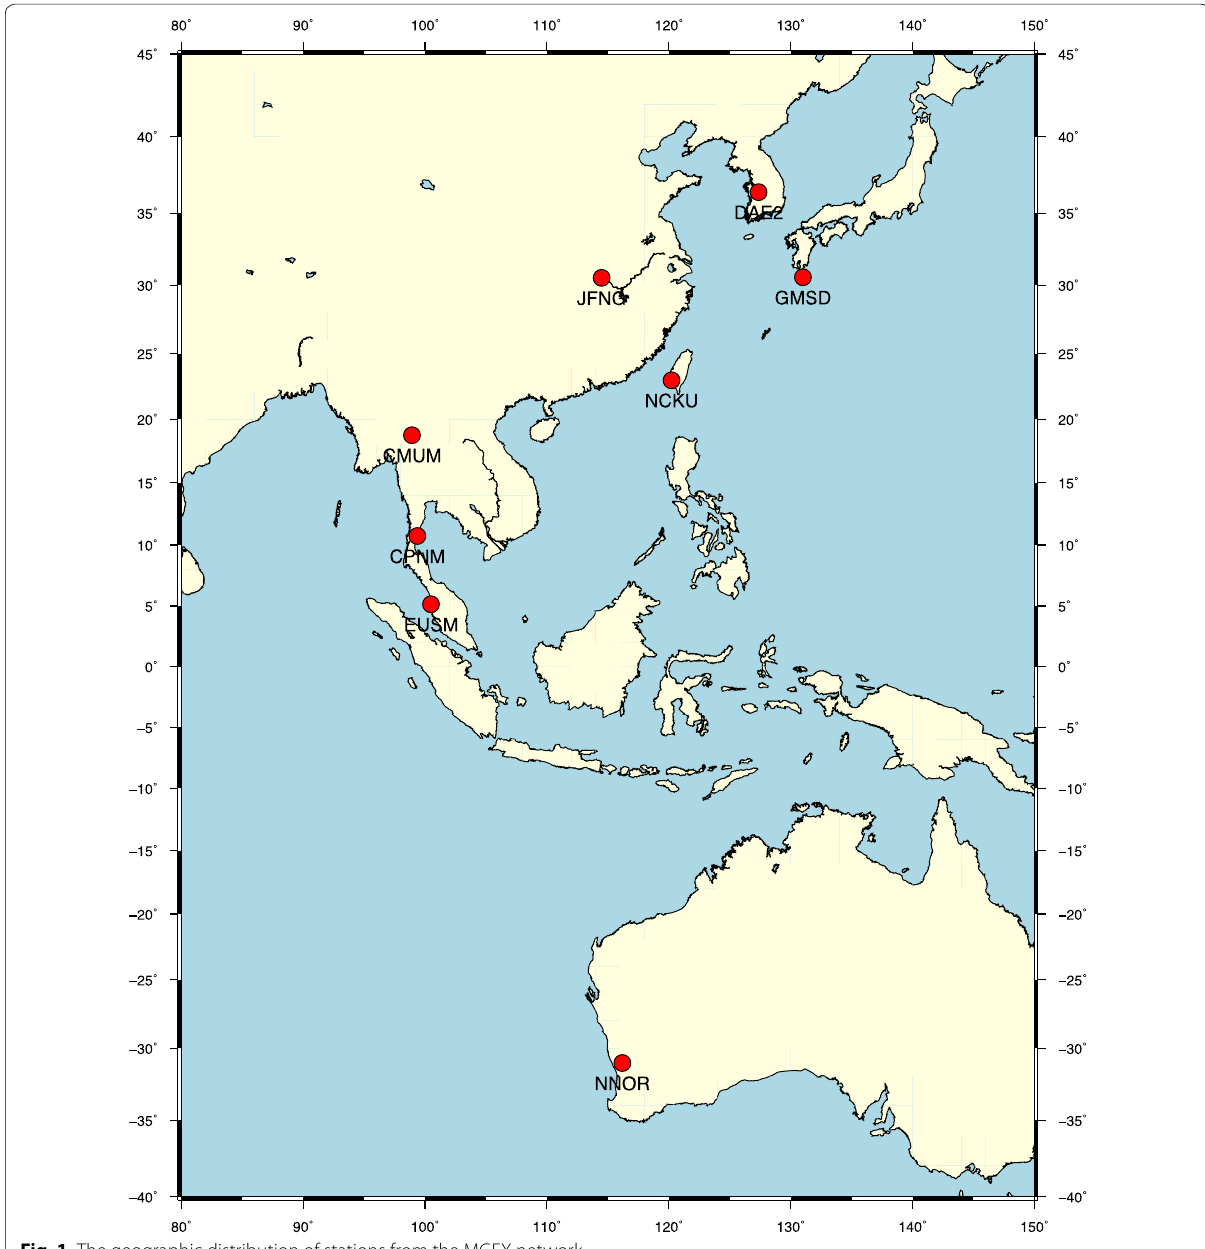
Fig. 1 The geographic distribution of stations from the MGEX